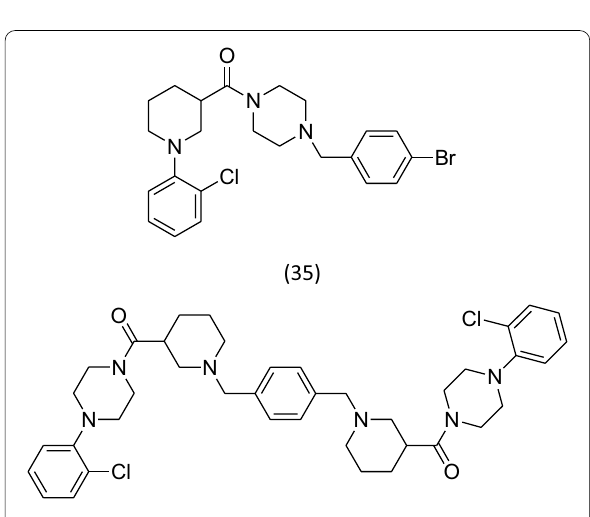
Fig. 36 Structure of 4‑(piperidin‑1‑yl)pyridine derivatives